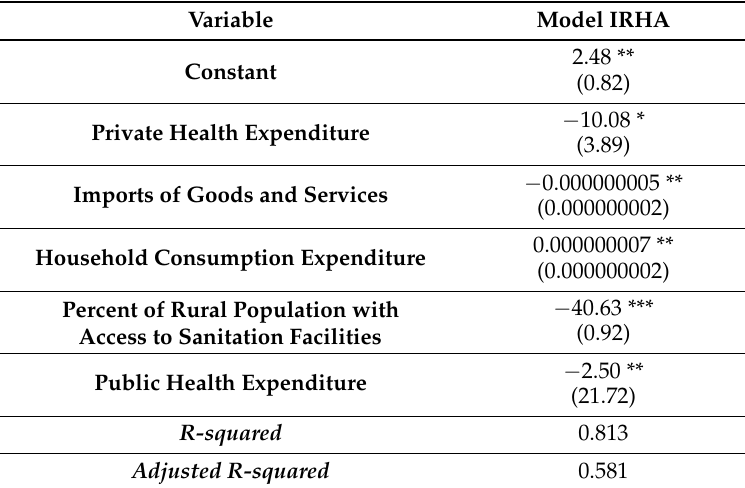
Table 4. Factors influencing the incidence rate of hepatitis A in Jordan (years